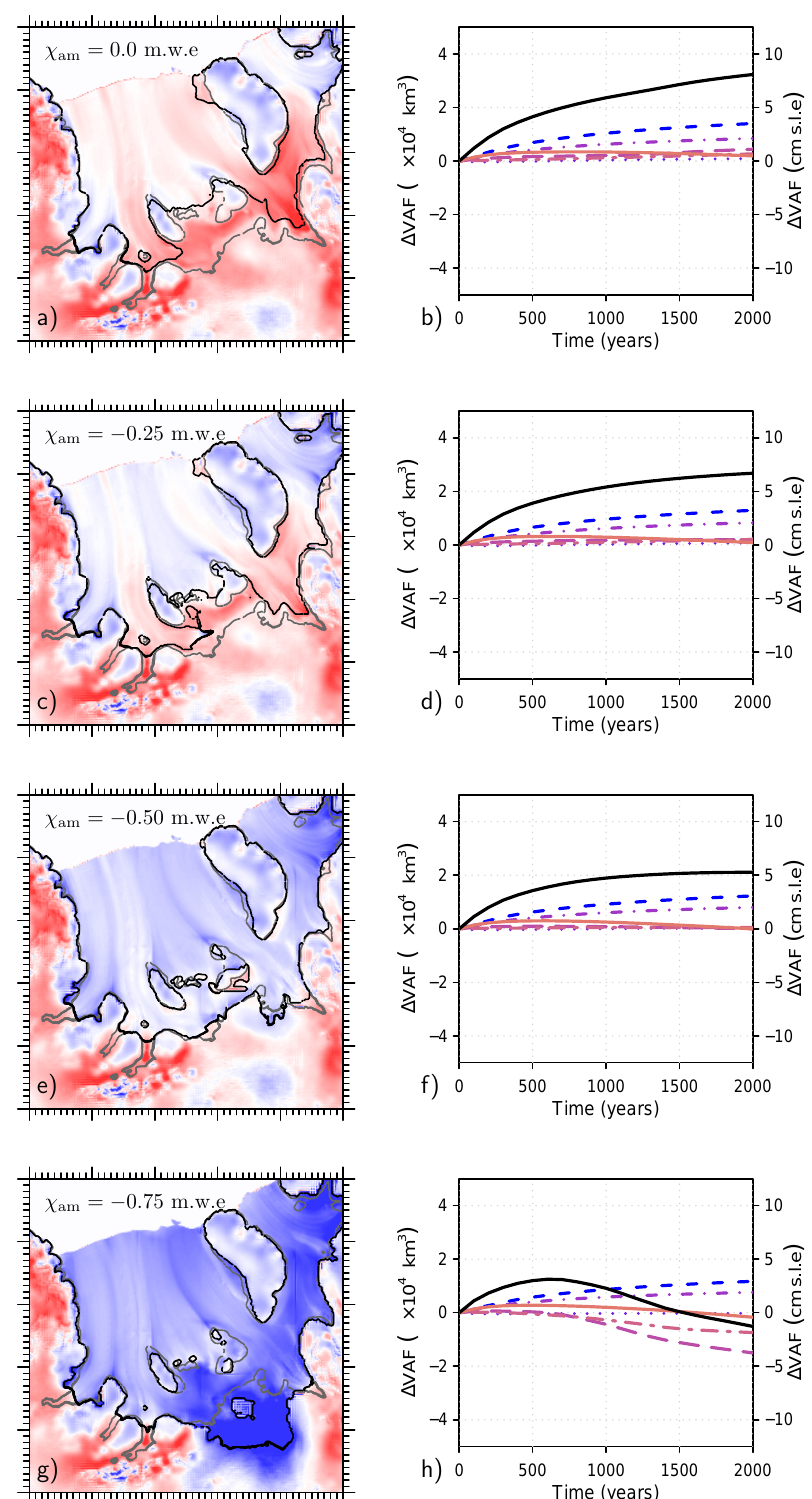
Figure 10. Results of modelling experiments where the grounding lines of ice rises within the Filchner–Ronne Ice Shelf have been iso- lated and the ambient melt field applied. The ambient field has then been shifted by ( a and b ) 0.0mw.e., ( c and d ) − 0 . 25mw.e., ( e and f ) − 0 . 50mw.e. and ( g and h ) − 0 . 50mw.e. in order to test the effect on the ice streams of the removal of the buttressing these ice rises provide to the ice